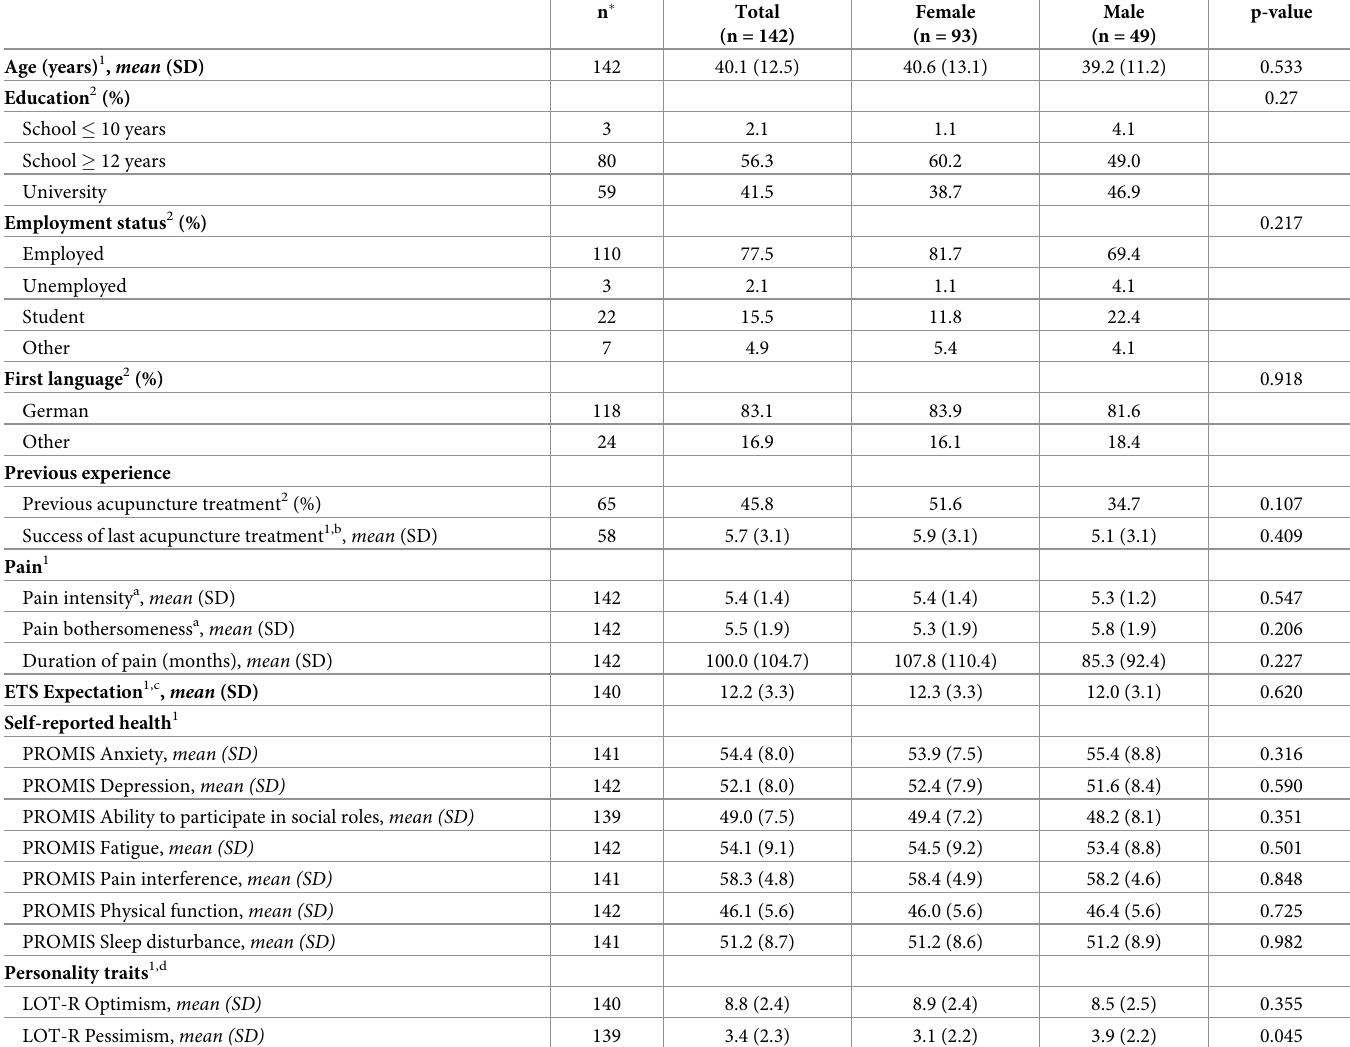
Table 1. Patients’ demographic and clinical characteristics stratified by